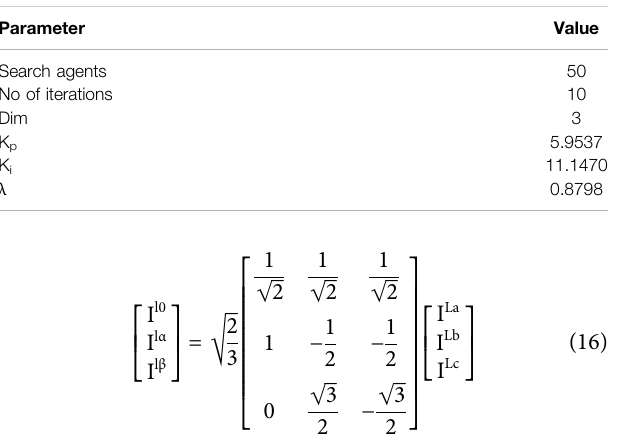
TABLE 3 | FOPI controller